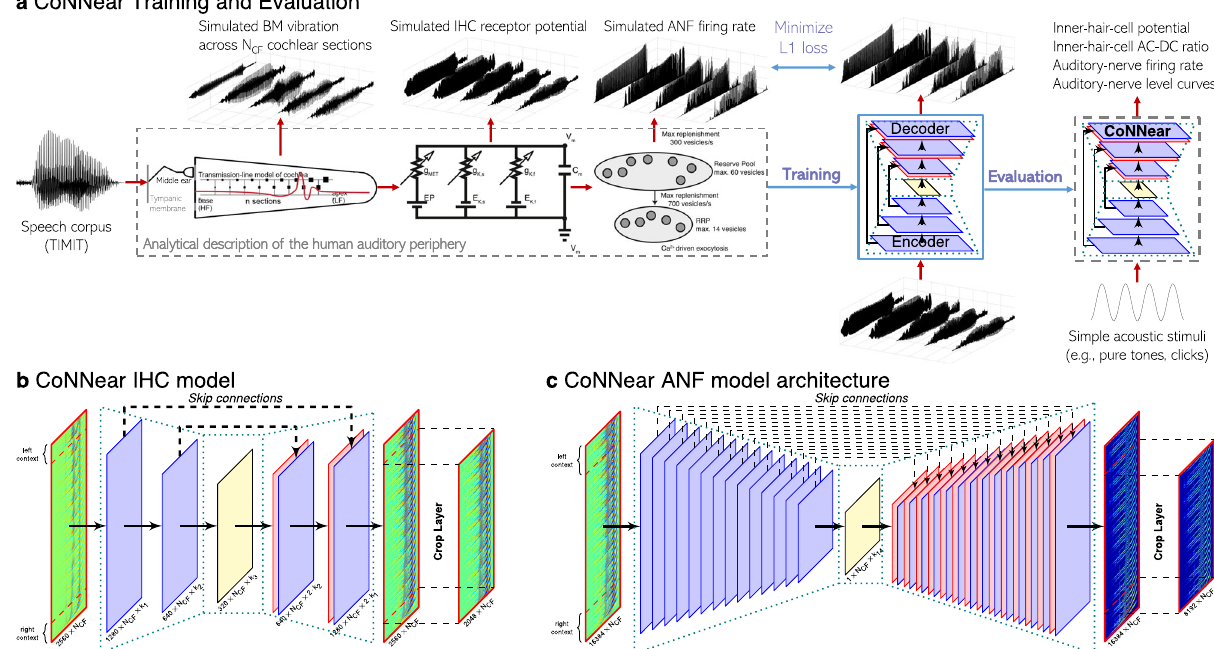
Fig. 1 CoNNear overview. a Overview of the CoNNear model training and evaluation procedure. b Architecture of the CoNNear inner-hair-cell transduction model. c Generic architecture used for the CoNNear auditory-nerve- fi ber synapse